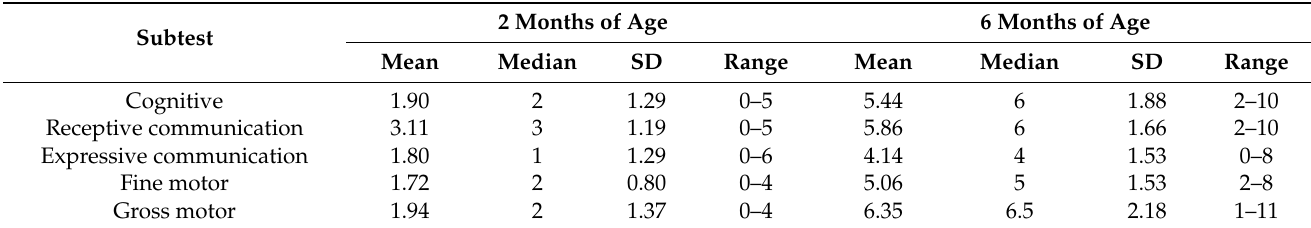
Table 4. The BSID–III screening test scores of infants at 2 and 6 months of age ( n =